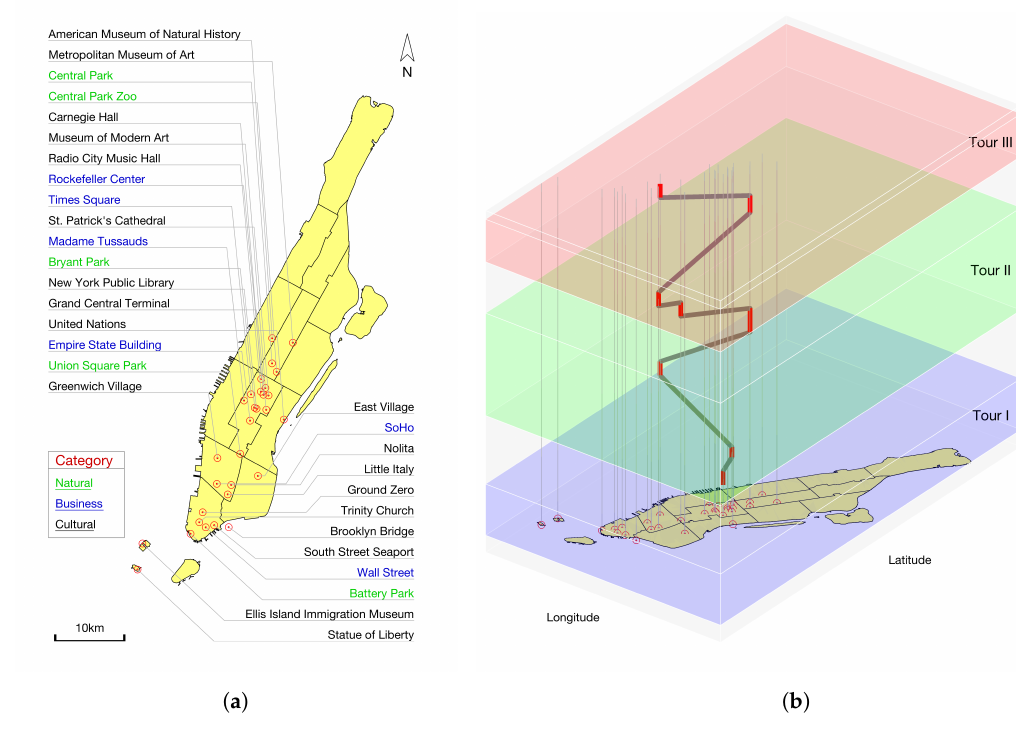
Figure 2. ( a ) Top 30 popular landmarks and ( b ) an example travel path in